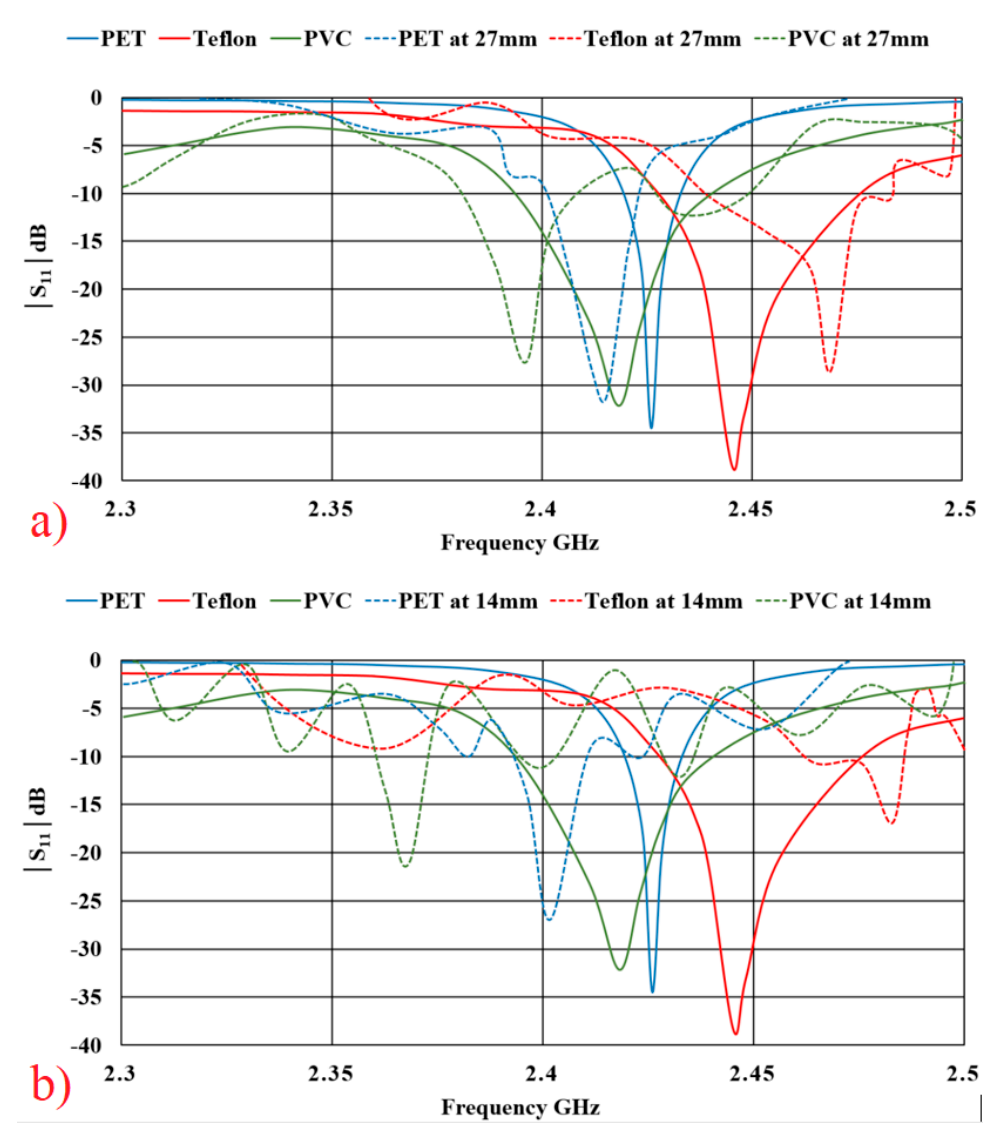
Figure 13. Operating at 2.45 GHz, reflection coefficients of E-shaped flexible polymer substrate antennas on PET, Teflon, and PVC substrates non-bent and with bending: ( a ) 27 mm, ( b ) 14 mm.